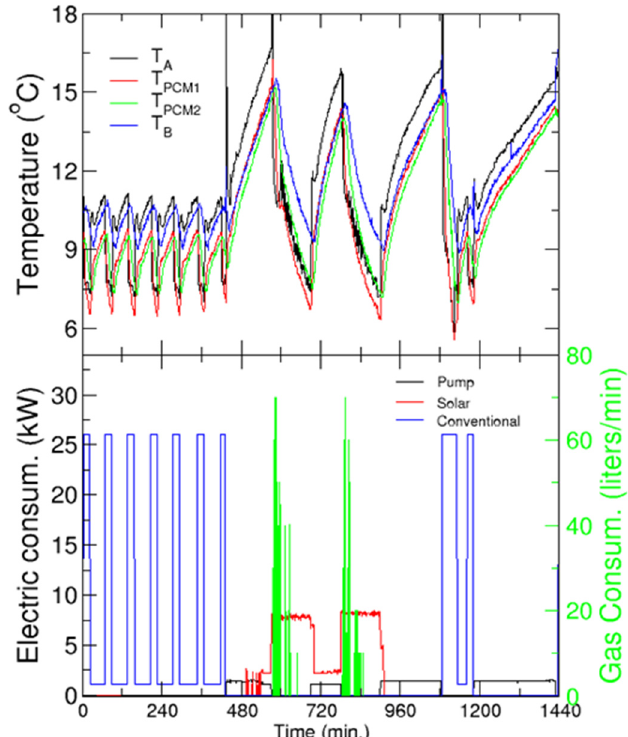
Figure 16. Cooling application. Upper panel: Evolution of the temperatures before (T A ) and after (T B ) the PCM tanks and in the tanks. Lower panel: Electric and gas consumption as a function of solar time—left and right axis, respectively. Every charging / discharging period is identified by the decrease / increase of the temperature in the tanks, and by the energy consumed.